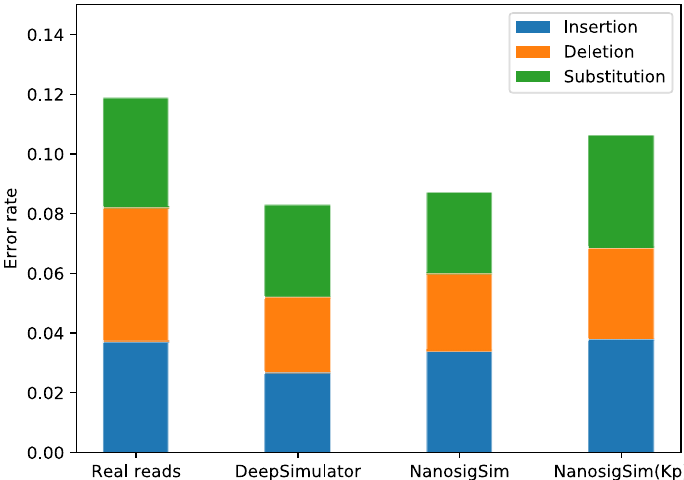
Figure 12. The profiles of different types of reads, tested on the Klebsiella pneumoniae sample, which are basecalled using Guppy. NanosigSim (Kp) means using the custom model for Klebsiella pneumoniae to generate simulated reads. Compared with the other two simulated reads, the simulated reads generated by NanosigSim (Kp) are more similar to the real reads in terms of error